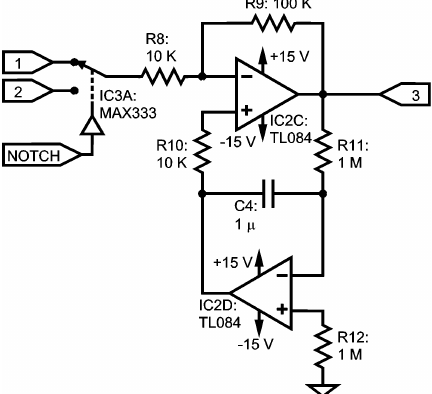
Figure 6. High-pass filter with a gain of 20 dB in the passband. Label #1: from IA; #2: from notch filter; #3: HPF